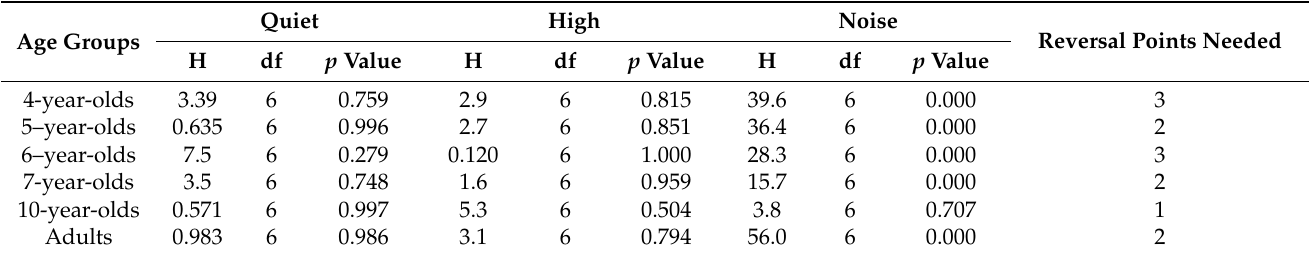
Table 5. Independent samples Kruskal–Wallis Tests for Reversal Points across quiet, noise and high frequency